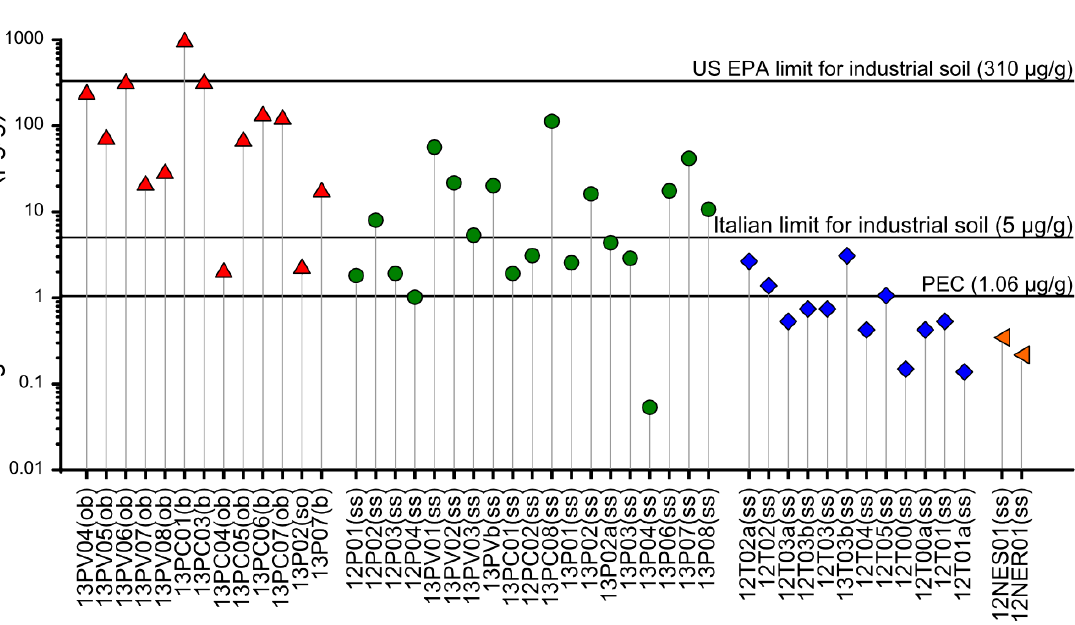
Figure 6. The semi-logarithmic scale graph shows the 2012 and 2013 total Hg concentrations in all samples compared with the probable effect concentration (PEC), Italian and U.S. Environmental Protection Agency (EPA) limits for industrial soils. Red triangles represent soils, bank and overbank sediment collected along the Paglia River; green circles and blue squares represent stream sediment total Hg concentrations of the Paglia and Tiber rivers, respectively, while orange triangles symbolize stream sediment collected along Nestore Creek and Nera River. The latter two sites are considered regional baseline sites, located upstream of the known mining impact. The analytical error is below